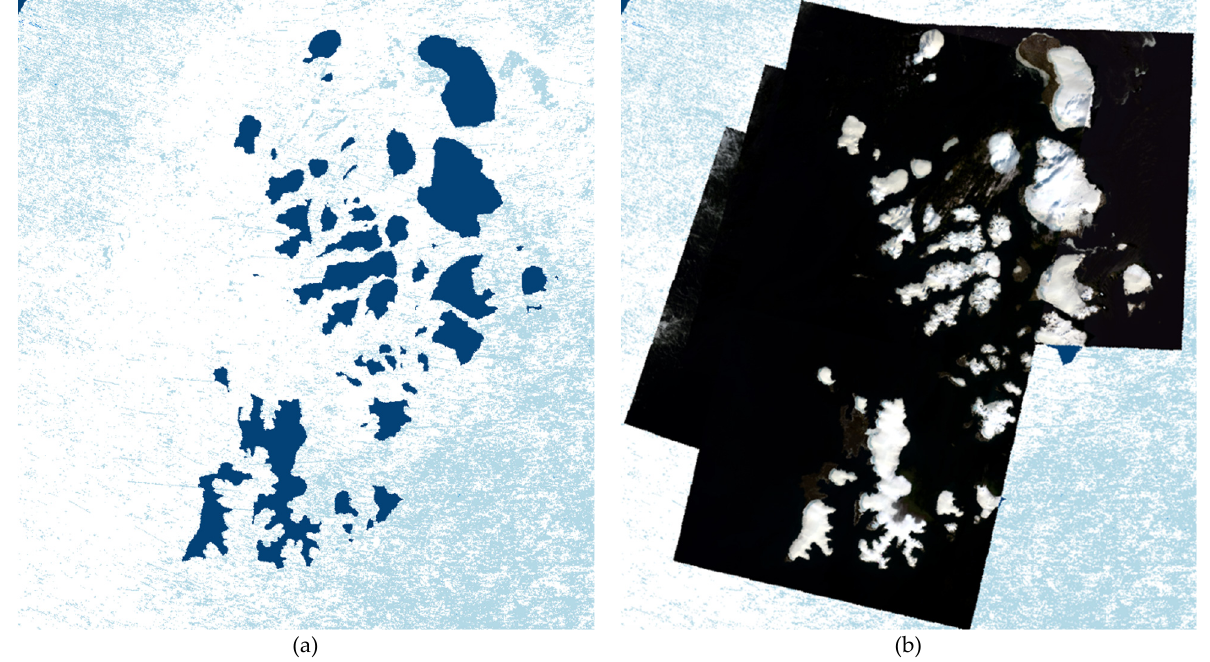
Figure 8. Comparison of ( a ) MISR-derived roughness map with ( b ) Landsat 8 for the ice-free area around the Zemlya George archipelago for a cloud-free period from 10–15 July 2016. Dark-blue patches in our MISR-derived map is the Zemlya George island.